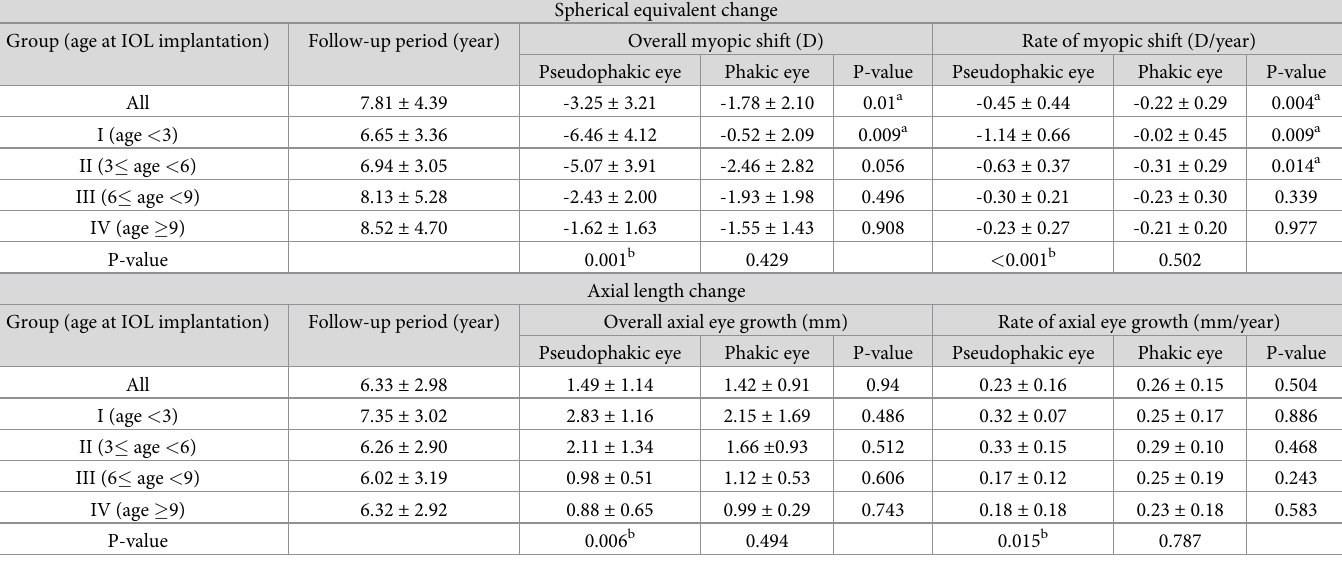
Table 3. Comparison of myopic shift and axial eye growth of pseudophakic eyes and fellow phakic eyes during the total follow-up period after unilateral pediatric cataract